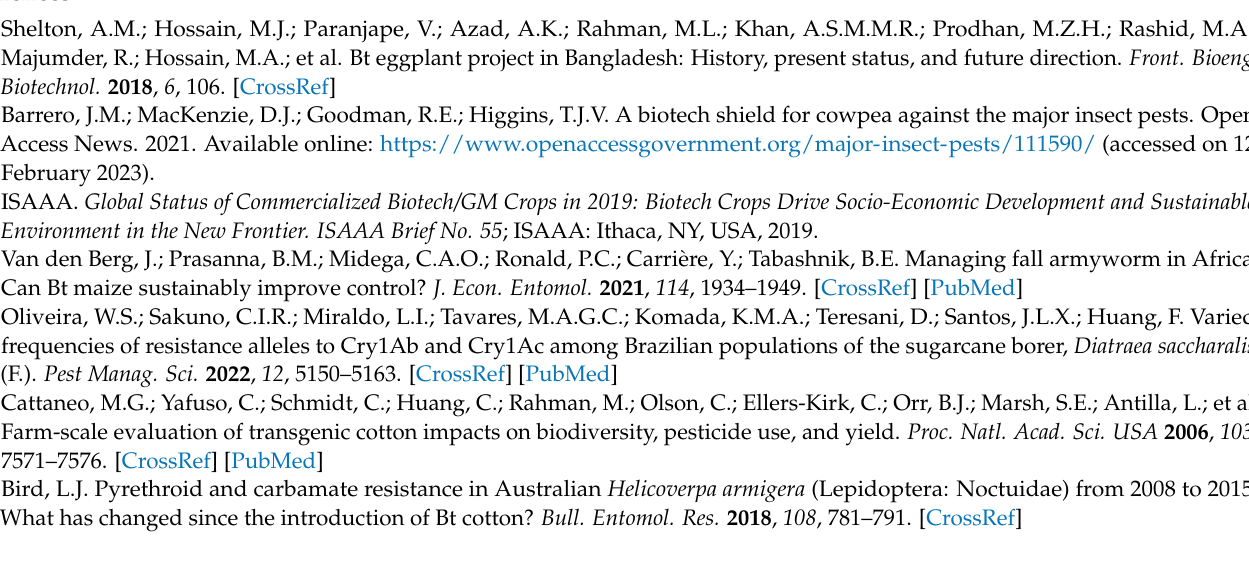
Table S3: Fitness of the genotypes on the non-Bt and Bt crop used in